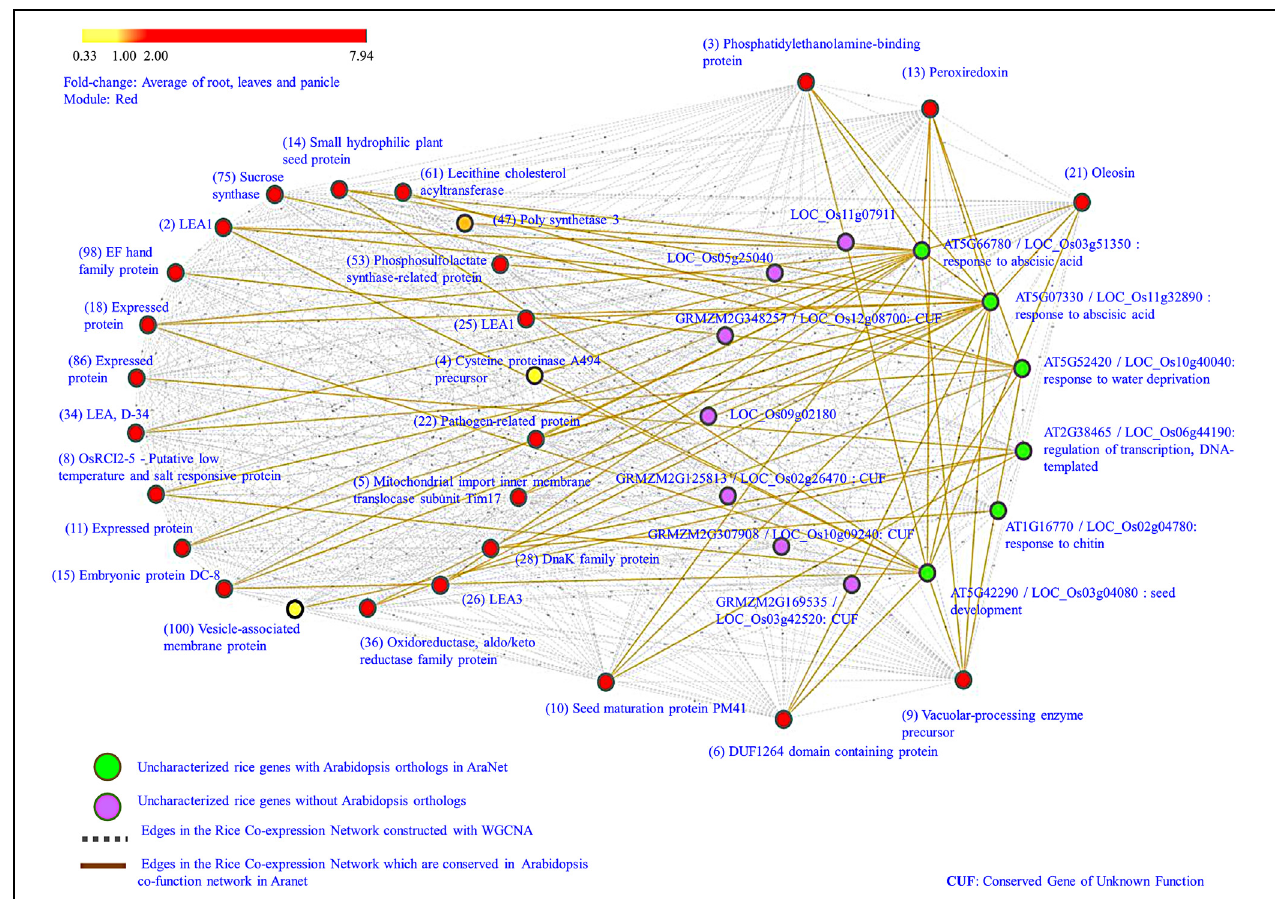
FIGURE 3 | Uncharacterized genes in red module. Genes that are high degree and up-regulated across all developmental stages and tissues are depicted in ‘green’ color (having Arabidopsis orthologs) and ‘purple’ color (having no Arabidopsis orthologs). Their neighbors, identified as orthologs in the co-function network in AraNet are colored according to the average